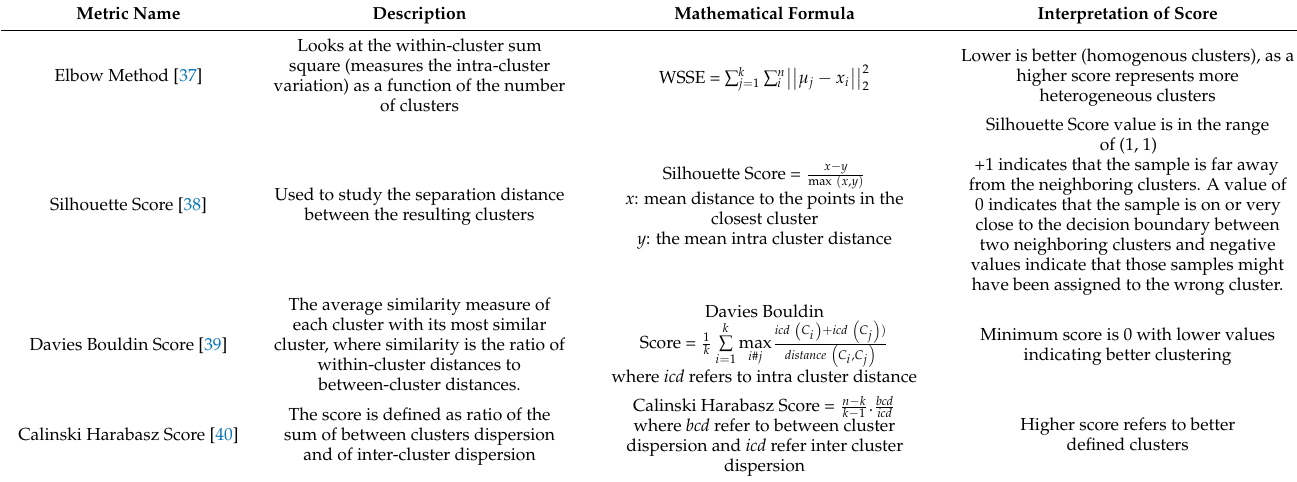
Table 3. Different clustering metric techniques used in the analysis.